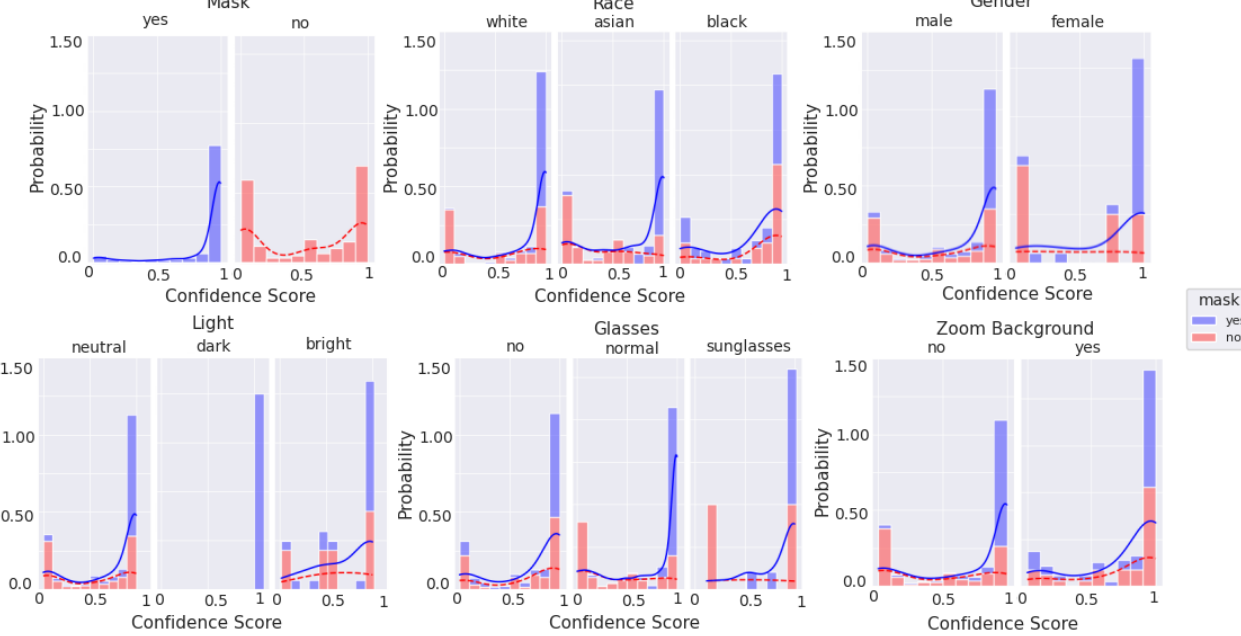
Figure 13. Histogram of categorical labels vs. confidence scores for only good quality images, as evaluated via BRISQUE using the augmented MobileNetv2 model. For each category and its labels, ‘mask’ and ‘no mask’ data bins are stacked. The solid and dashed lines represent the KDE for ‘mask’ and ‘no mask’ image scores,